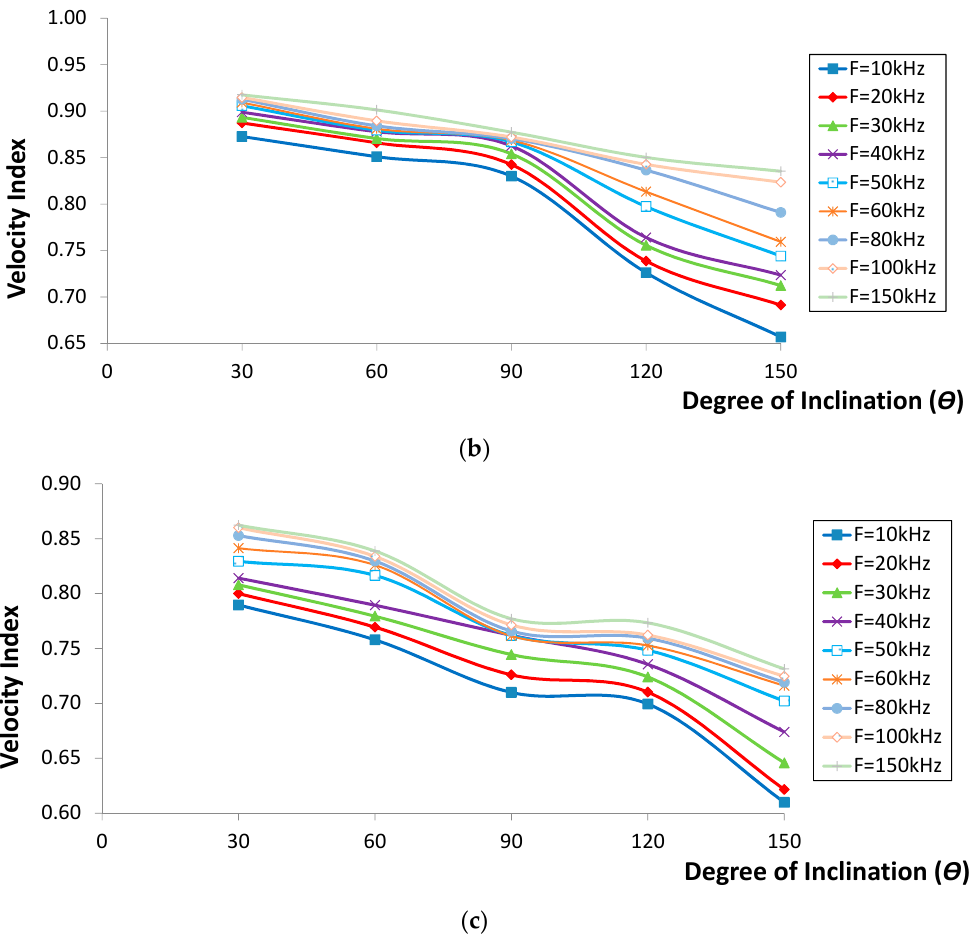
Figure 7. Velocity index versus different degree of inclination for crack depth of ( a ) 30 mm, ( b ) 90 mm and ( c ) 150 mm.